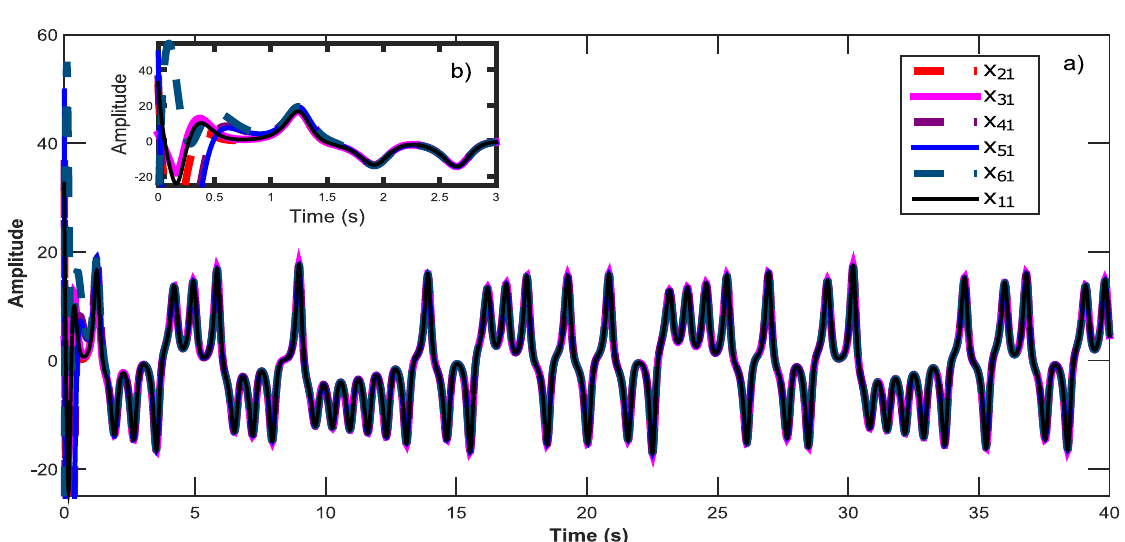
Fig 13. a) Output Synchronization for six nodes using three different chaotic systems in a Tree topology with two master systems. b) Zoom in window showing the convergence in time for all x